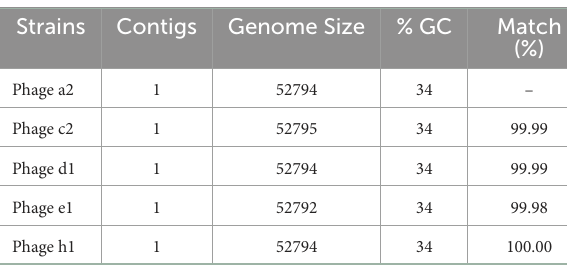
TABLE 3 A5-miseq assemblies of the bacteriophages